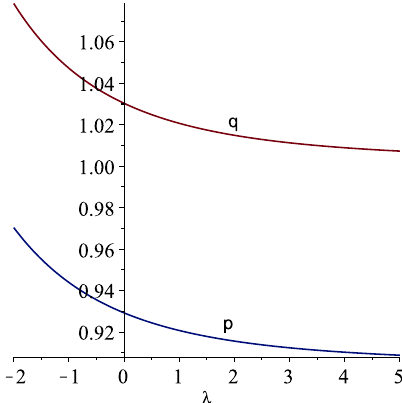
Figure 2. The graphs of p ( λ ) = k ( λ ) and q ( λ )